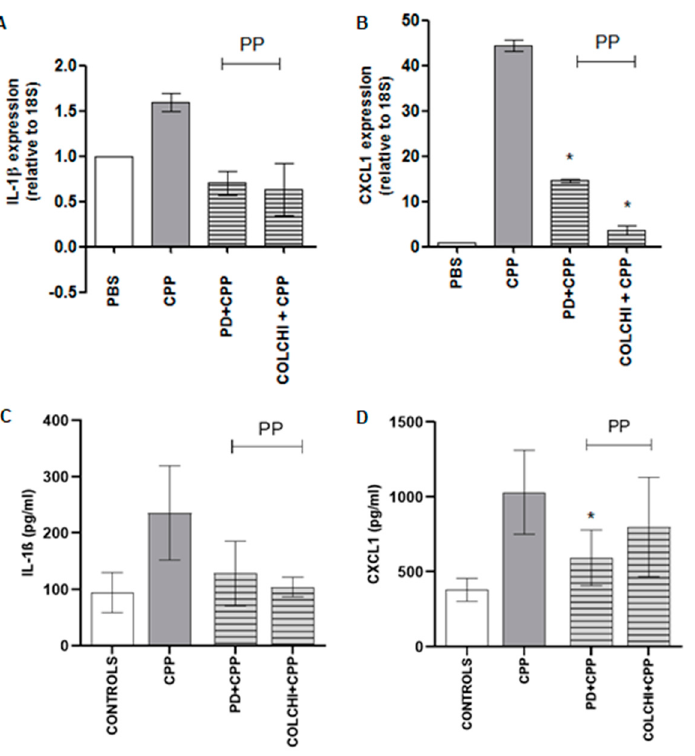
Figure 4. Variation in IL-1 β and CXCL1 mRNA tissue levels ( A , B ) and serum levels ( C , D ) after CPP crystal injection in the prophylactic (PP) protocols. Mice received an i.a. injection of CPP crystals (0.3 mg/20 µ L) and were treated with PD (40 mg/kg) or colchicine (1 g/kg) according to the group allocation ( n = 8/group). Tissues were immediately stored in RNA-stabilizing reagent after sacrifice. * p < 0.05 vs. CPP. Cytokines were measured in blood collected by intracardiac puncture and after centrifugation. * p < 0.05 vs. CPP.